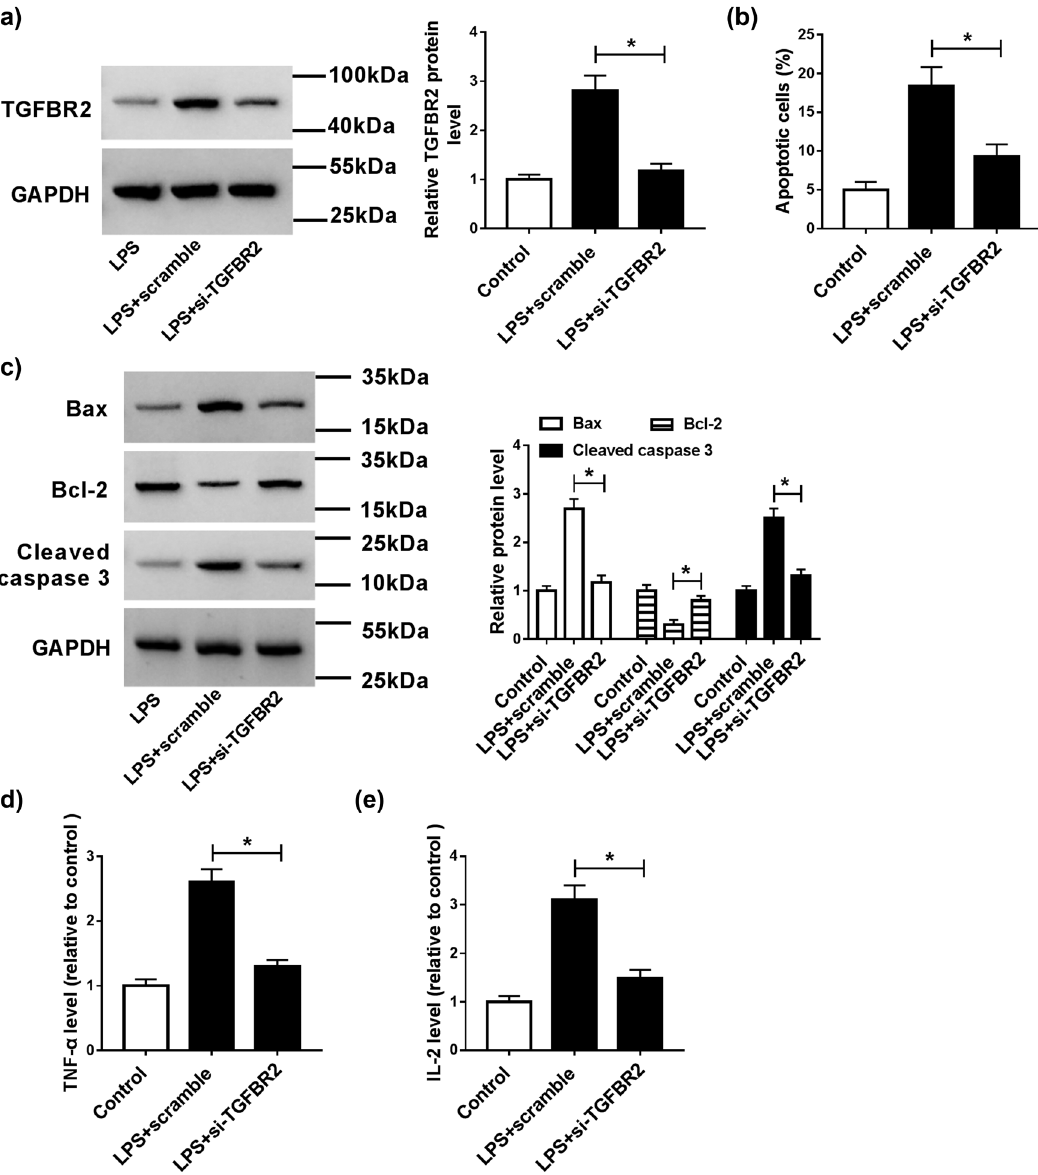
Figure 3: E ff ects of TGFBR2 on apoptosis and in fl ammation in LPS - induced HK2 cells. HK2 cells were treated with LPS or/and transfected with si - TGFBR2. ( a ) The protein level of TGFBR2 was measured by western blot analysis. ( b ) Cell apoptosis was detected by the fl ow cytometry. ( c ) The protein levels of Bax, Bcl - 2, and cleaved caspase 3 were analyzed by western blot. ( d and e ) ELISA kit was used to determine the production of pro - in fl ammatory cytokines ( TNF - α and IL - 2 ) . * P <